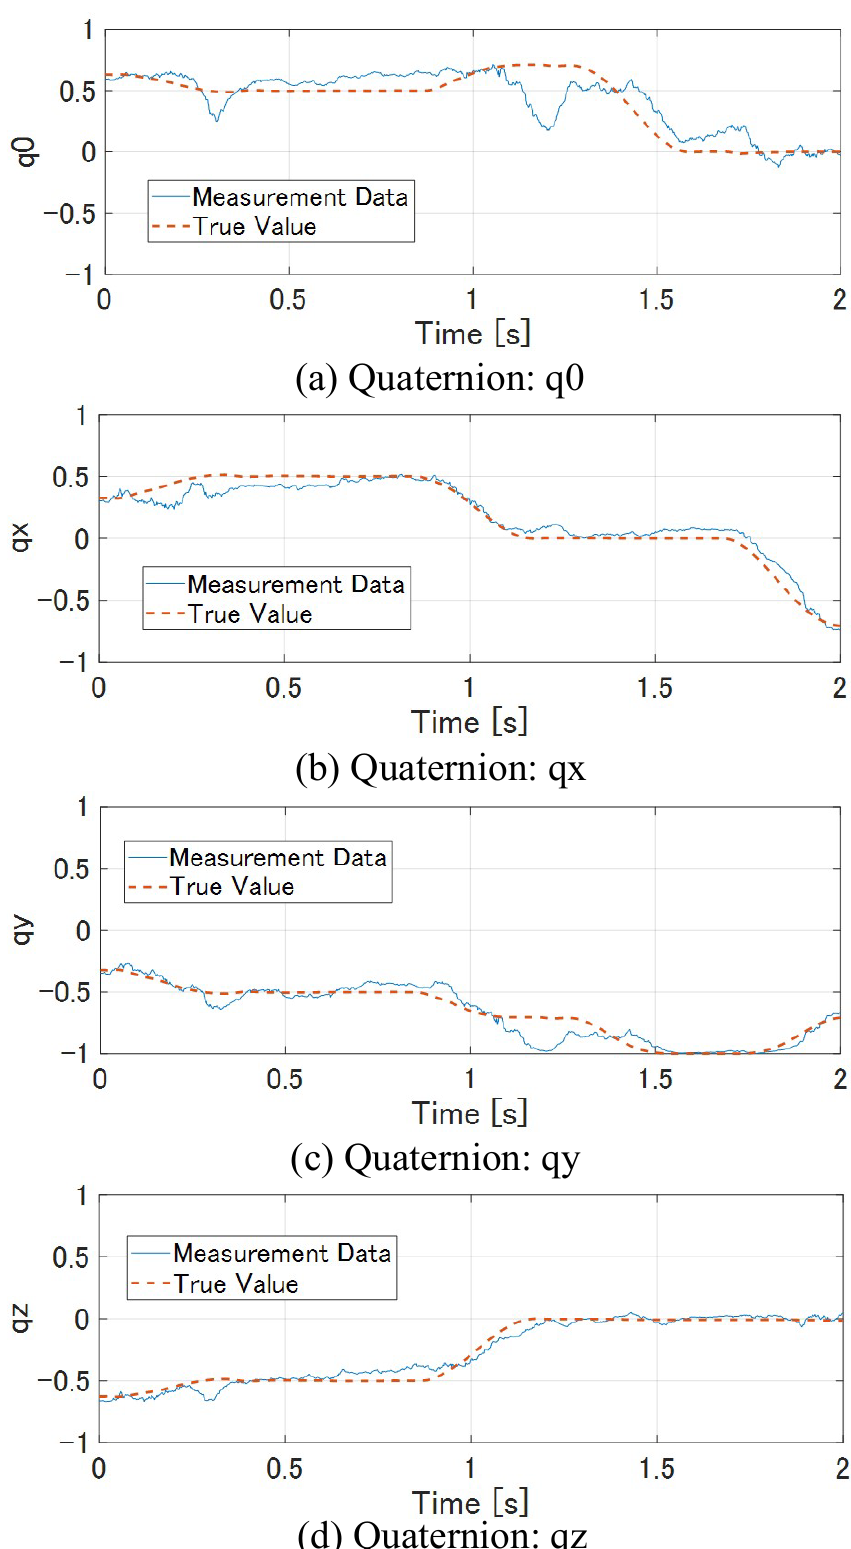
Figure 16. Quaternion of ken